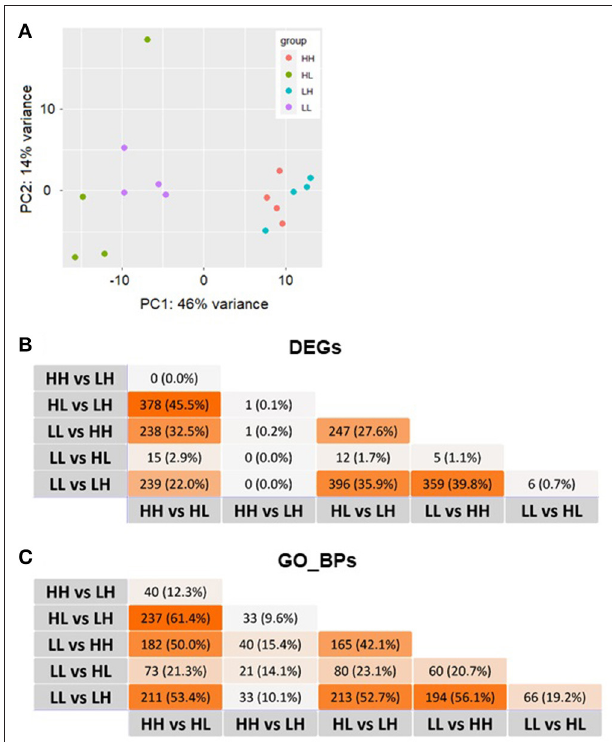
FIGURE 2 | (A) Plot of the first 2 principal components (PCs) of the normalized read counts. (B) Overlaps of differentially expressed genes (DEGs) and (C) the corresponding enriched Gene Ontology biological processes (GO_BPs) among all comparisons. No DEGs and/or GO_BP terms overlapping among all comparisons performed were identified. L, low food availability; H, high food